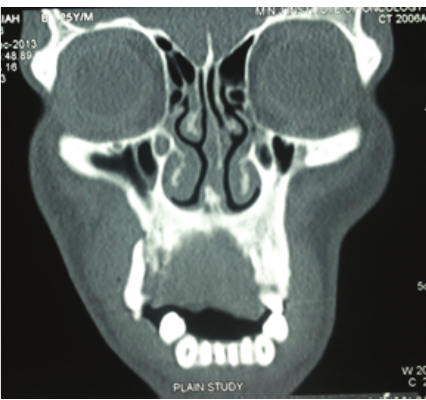
Figure 4: Strips of squamous epithelium with proliferation of tumor cells arising from basal layer infiltrating deeply into the stoma. Individual cells are round to spindle with melanin pigment.